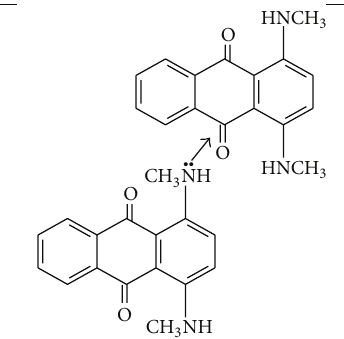
Scheme 2: Intermolecular excimer of CFBB.